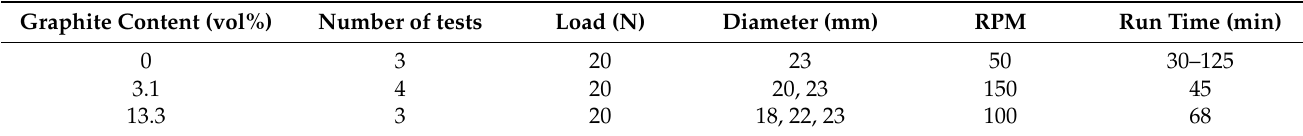
Table 3. Load parameters for the wear